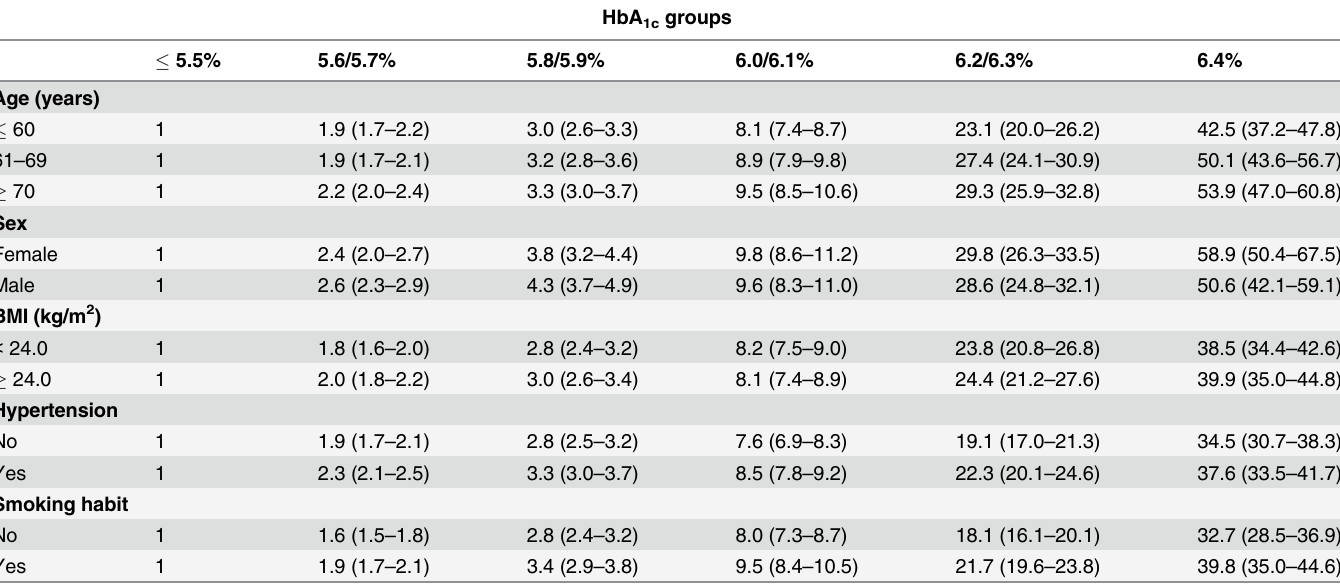
Table 3. The risk of diabetes incidence based on the baseline HbA1c levels after the stratification of major risk factor in the Cox proportional-haz- ard model.